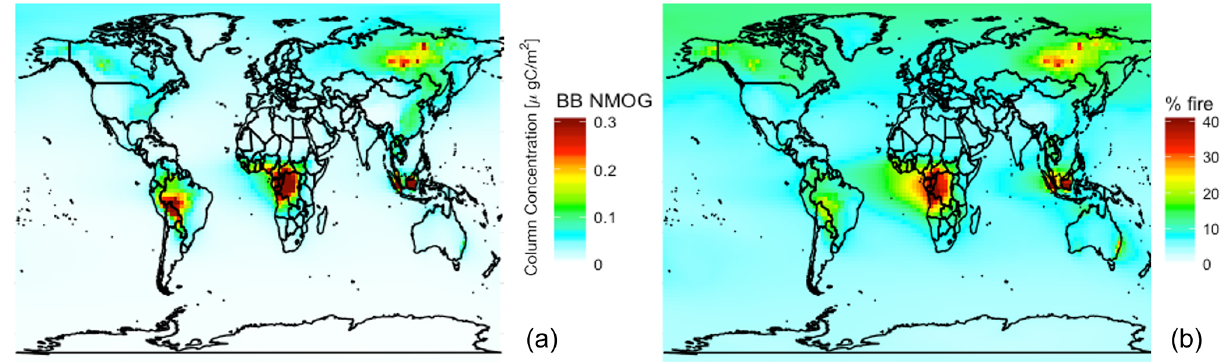
Figure 7. 2019 annual mean simulated (a) NMOG total column concentrations from fires and (b) percent contribution of NMOG total column concentrations from fires.